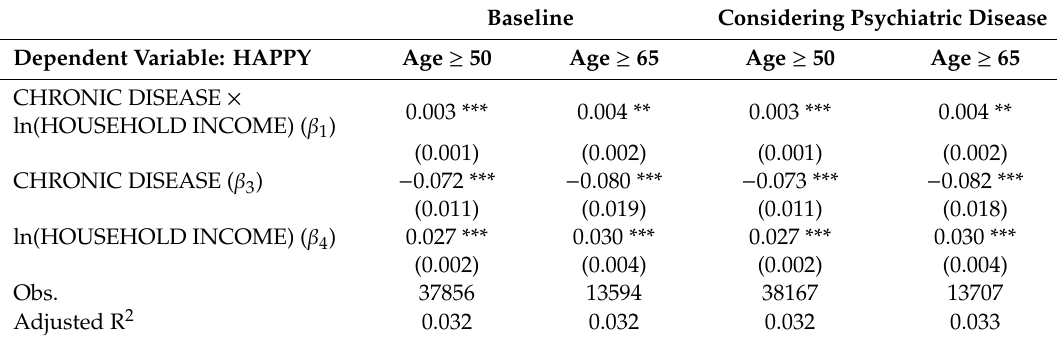
Table 9. Including psychiatric